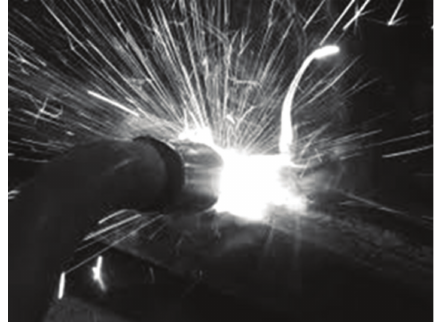
Figure 2: Opening for electric arc welding